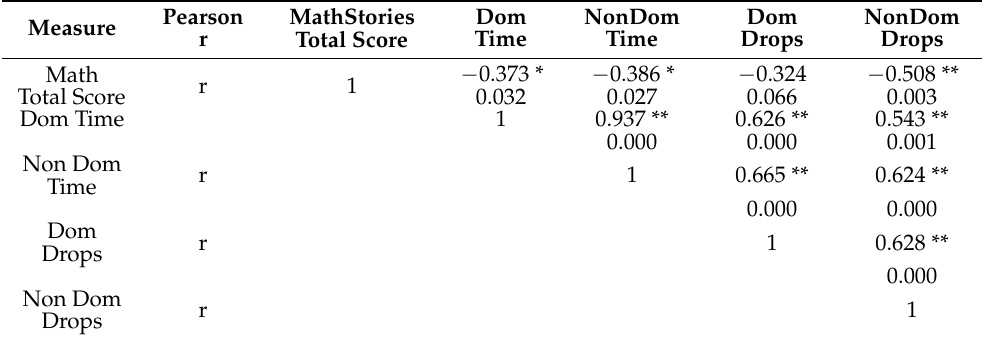
Table 6. Math Stories and Grooved Pegboard Correlations (n =